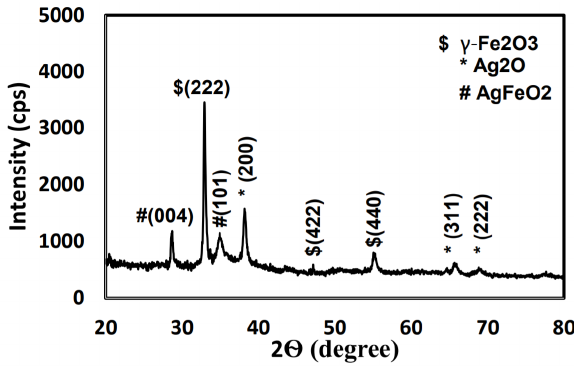
Figure 1: XRD pattern of 𝛾 -Fe 2 O 3 -Ag 2 O nanocomposite.